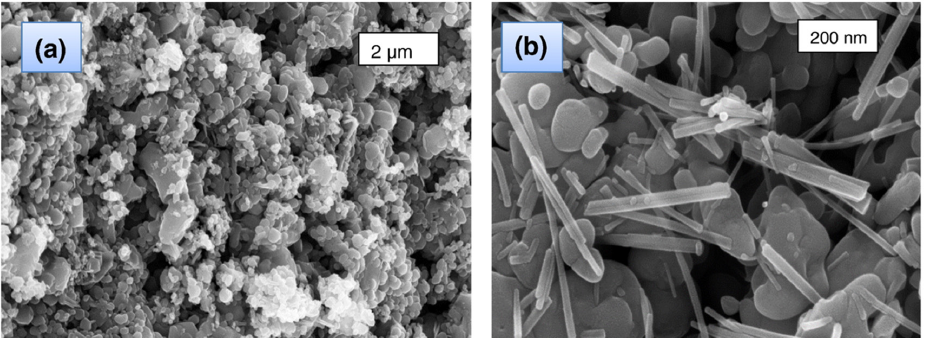
Figure 6. SEM analysis of ZnO-NPs: ( a ) 200 °C (spherical shape) and ( b ) 800 °C (nanorods) [72].